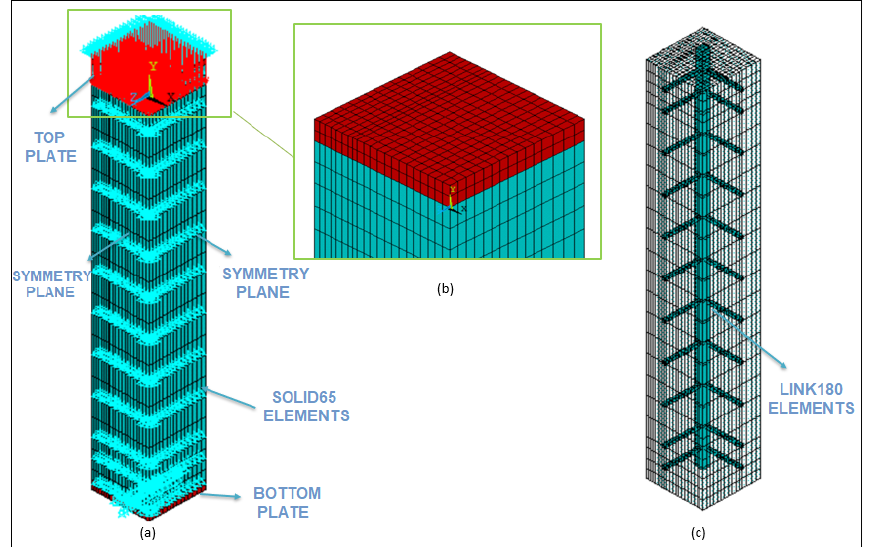
Figure 7. (a) Generic mechanical/thermomechanical model (b) top plate detail (c) arranging of longitudinal and transversal